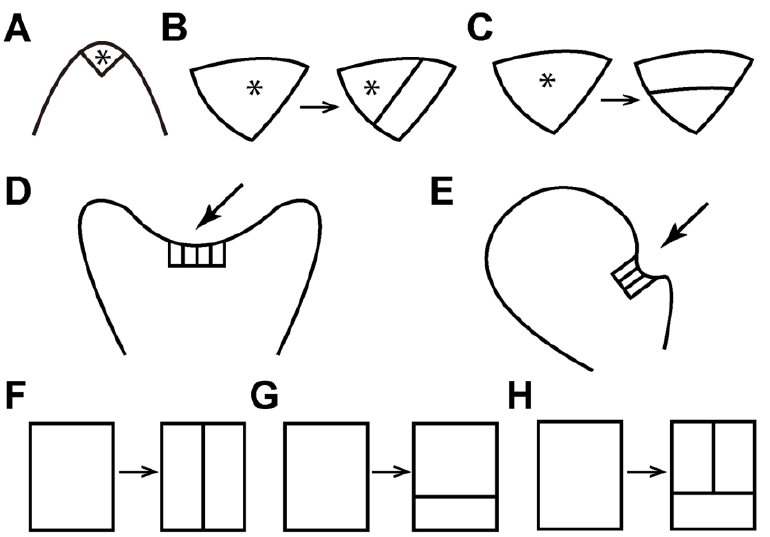
Figure 2. Diagrams illustrating different types of meristems and cell division patterns in fern gametophytes. ( A – C ) The asterisks indicate the wedge-shaped apical cells (ACs) in the AC-based meristem ( A ). The oblique division ( B ) is associated with the initiation and proliferation of ACs ( A , B ). The periclinal division in the ACs ( C ) usually leads to the disappearance of the ACs. ( D , E ) The arrows ( D , E ) indicate the multicellular apical meristem and the multicellular marginal meristem in fern gametophytes, respectively. ( F – H ) Diagrams of different patterns of cell division in multicellular meristems. The anticlinal division ( F ) is usually associated with the initiation of multicellular apical and marginal meristems. The anticlinal ( F ) and periclinal ( G ) divisions and the conserved reverse “T” type of divisions ( H ) are associated with the proliferation of multicellular apical and marginal meristems.